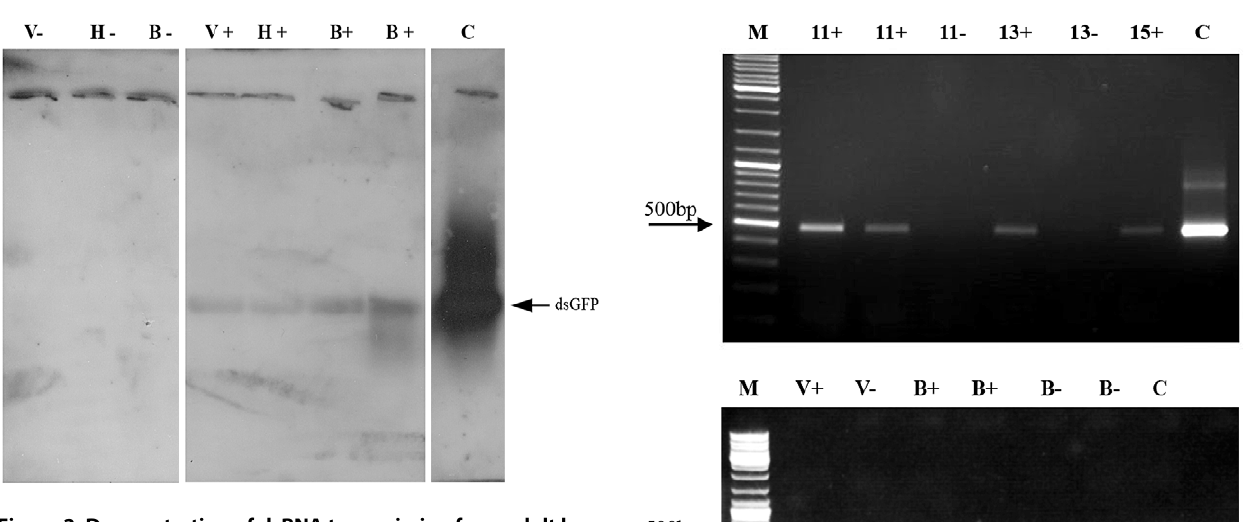
Figure 2. Demonstration of dsRNA transmission from adult bee to Varroa via the bee hemolymph. Northern blot assay was performed on RNA extracted from a bee that had ingested dsRNA- GFP (B + ) and from an untreated bee (B 2 ), pooled RNA extracted from hemolymph collected from bees that had ingested dsRNA-GFP (H + ) and from untreated bees (H 2 ), and pooled RNA extracted from Varroa mites parasitizing dsRNA-GFP-treated bees (V + ) and untreated bees (V 2 ). C=positive control (GFP-carrying plasmid). doi:10.1371/journal.ppat.1003035.g002 Figure 3. Demonstration of dsRNA transfer from bee to Varroa